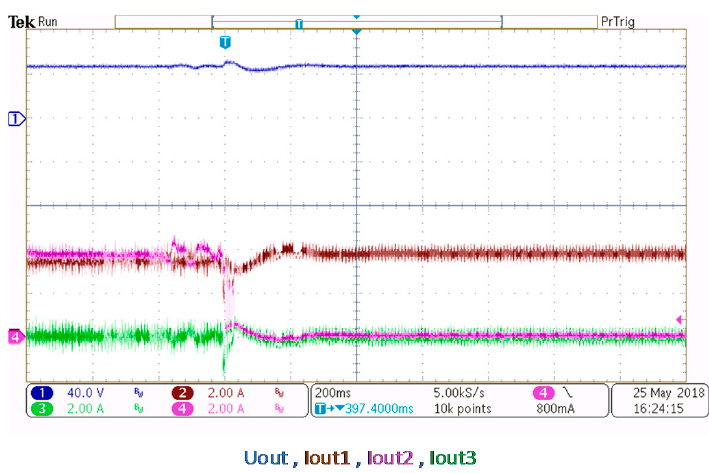
Figure 15. Experimental results from sequential switching of MASTER-voltage SLAVE-current control strategy ( P OUT = 35% to 15%) .